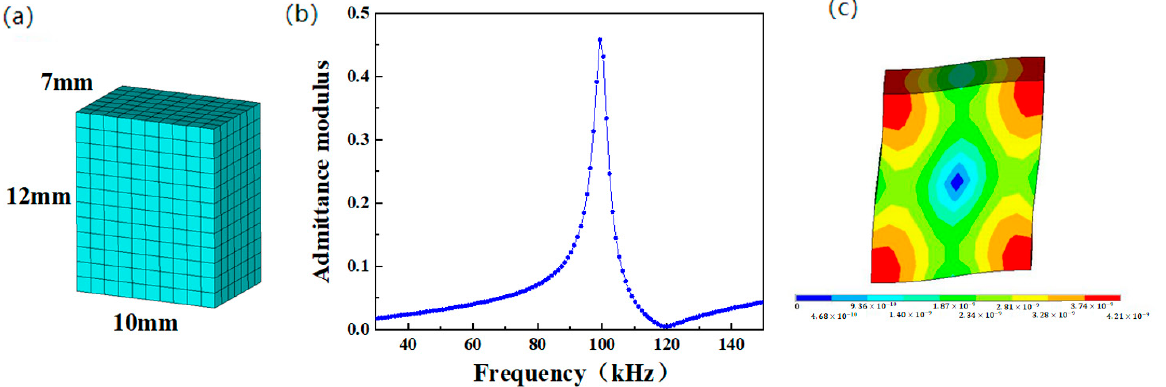
Figure 3. Finite element simulation results of single ceramic element. ( a ) Mesh model; ( b ) admittance modulus curve; ( c ) vibration mode.